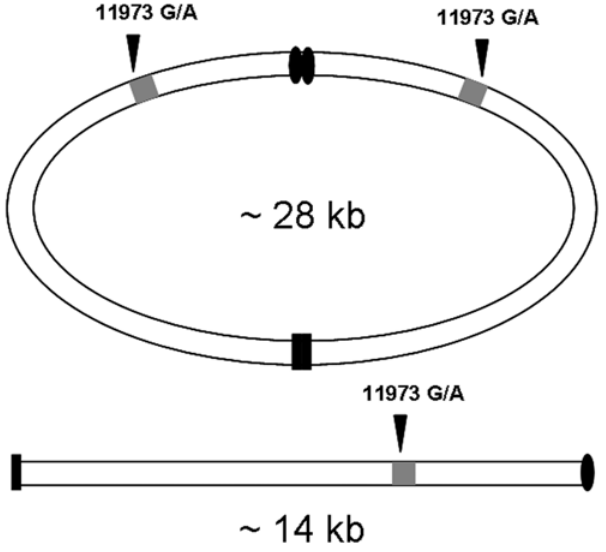
Figure 4. Secondary structure of the dual tRNA Ala/Val from the Armadillidium vulgare mitochondrial genome. The 11973G/A heteroplasmy is highlighted in the red rectangle, in the anticodon shown in yellow. Orange circles denote conserved nucleotides for mitochondrial tRNAs [20].